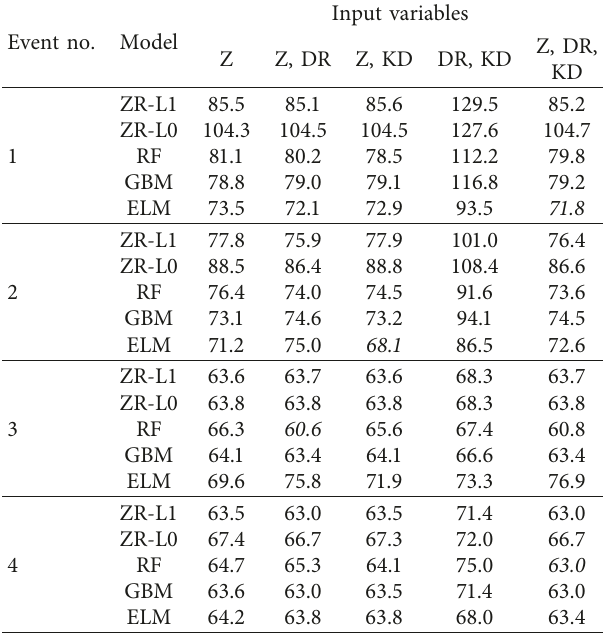
Table 6: Relative root-mean-square errors (RRMSEs) of rain rate estimations by quantitative precipitation estimation models for each selected rainfall